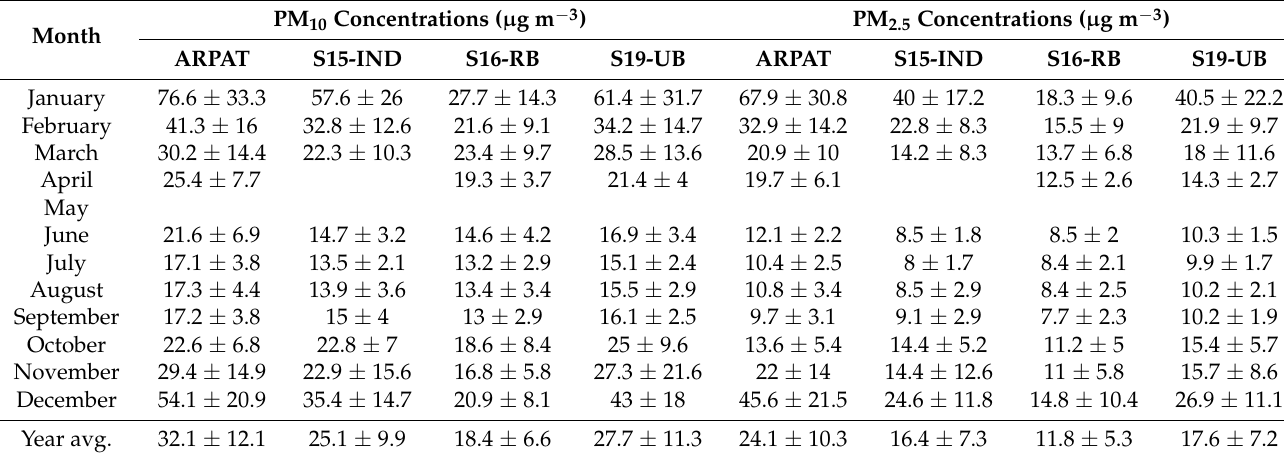
Table 3. Monthly averages and standard deviations of PM 10 and PM 2.5 concentrations observed by the three AirQino stations